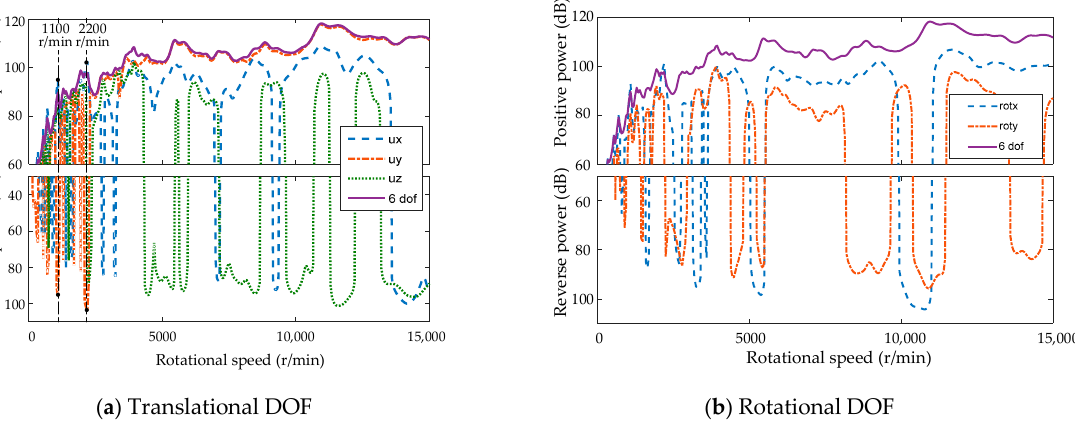
Figure 14. Bearing housing transmi tt ed power fl ow—direction path The transmi tt ed power of the housing isolator corresponding to the location path is shown in Figure 15. The power fl ow direction of each isolator is always positive, and there is no reverse power fl ow. At low speed, the contribution of each isolator to vibration is almost the same, but at high speed, the contribution of each isolator is di ff erent at di ff erent rotational speeds. For example, between 5400 r/min and 6700 r/min, isolators 3 and 4 have the greatest contribution to vibration, while the contribution of other isolators is relatively small. Between 10,700 r/min and 13,450 r/min, isolator 3 and 4 also contribute signi fi cantly to vibration. Although isolators 1 and 2, 3 and 4, and 5 and 6 are symmetrically arranged, the vibration power of the corresponding isolator is di ff erent because the transmission system is asymmetrical.